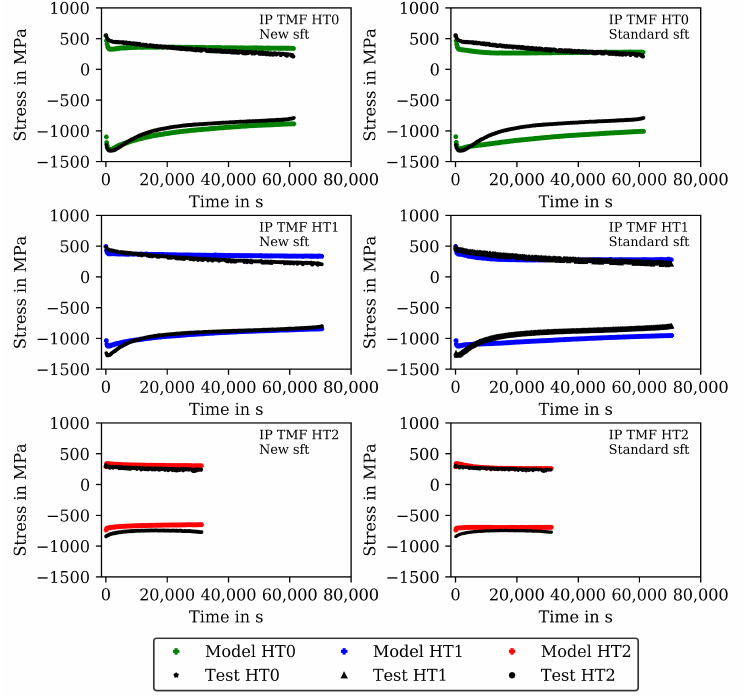
Figure 7. Stress–time diagrams for the measured stress and stress calculated with the viscoplasticity model for the in-phase TMF tests for the HT0, HT1, and HT2 material at the points of strain reversal (mechanical strain amplitude of 0.005). New isotropic-softening model ( left ) and standard isotropic- softening model ( right